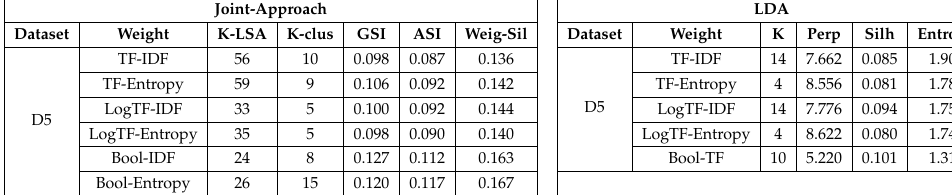
Table 9. Experimental results for D5.